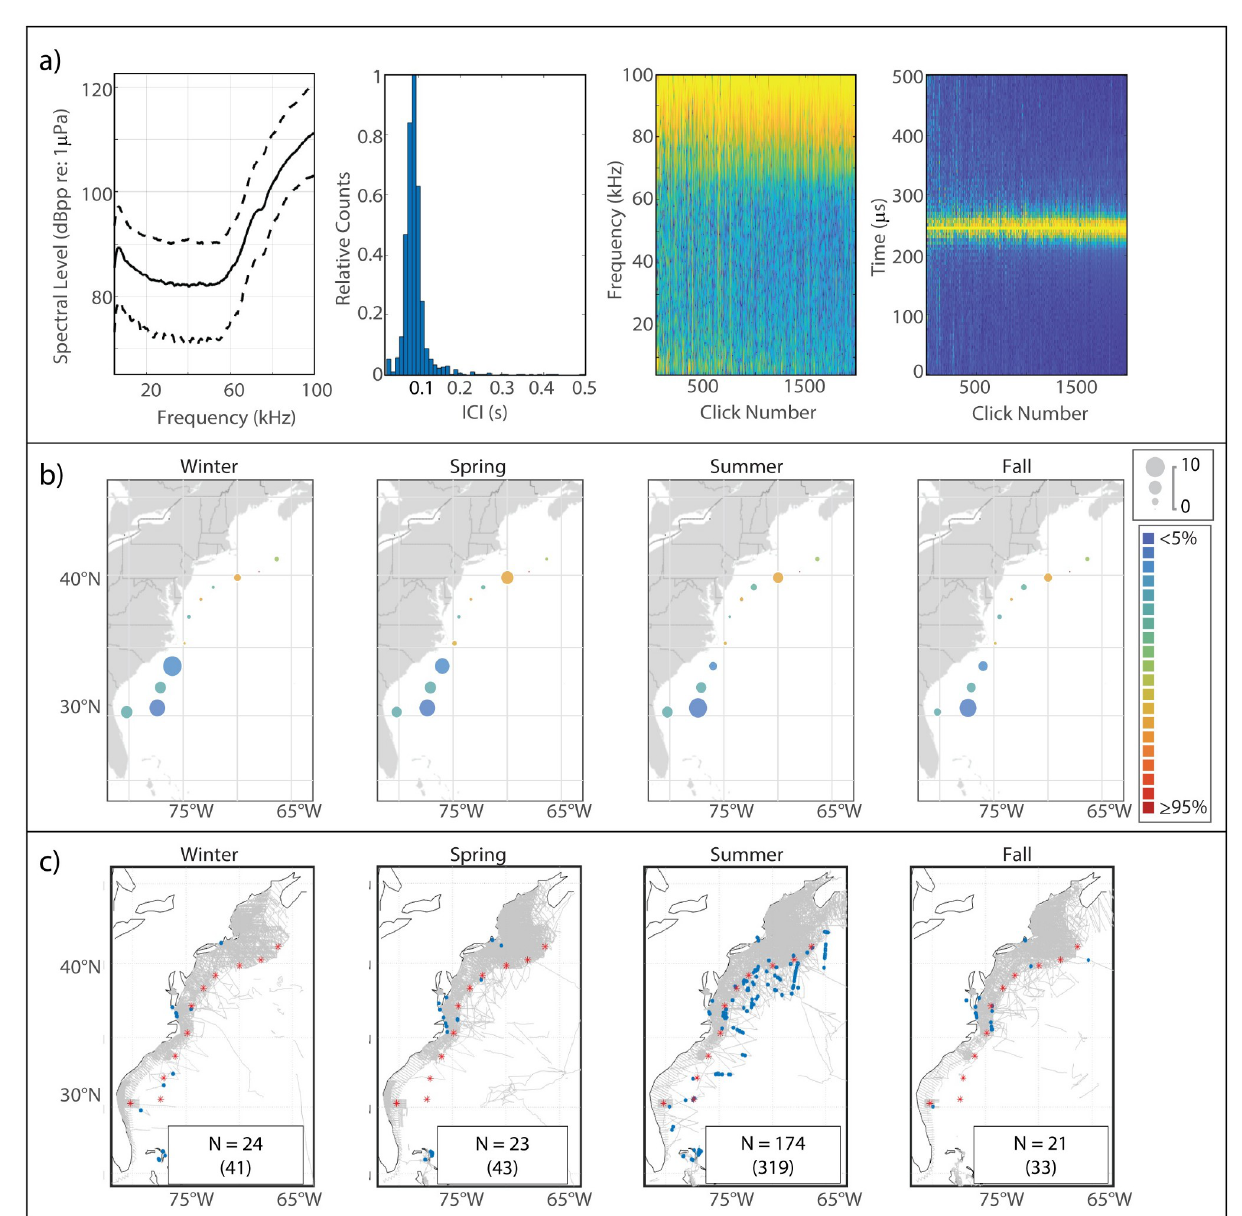
Fig 8. Results for Kogia spp . showing click type (a), acoustic presence (b), and historical sightings (c). Subplots as in Fig